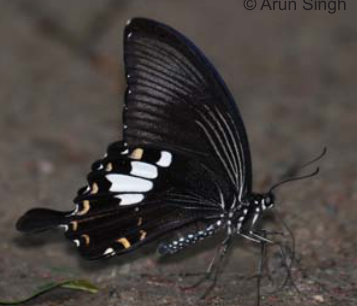
Image 16. Yellow Helen Papilio nephelus